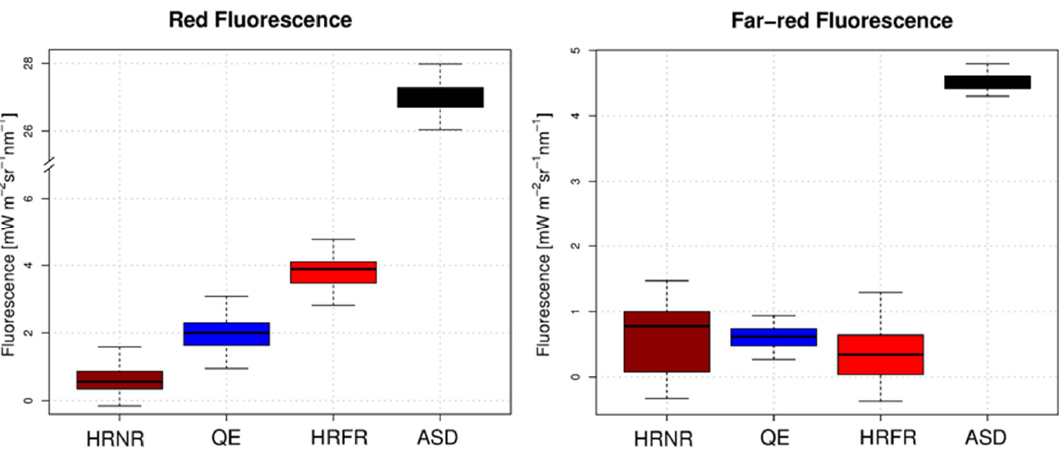
Figure 3. Boxplots of red ( left ) and far-red ( right ) Sun Induced chlorophyll Fluorescence (SIF) retrieval means and associated standard deviations of the 30 cycles of measurements. The instruments are reported in the order according to the increasing Full Width at Half Maximum (FWHM) and Spectral Sampling Interval (SSI). The red SIF estimations differ, indicating a possible dependency on the Spectral Resolution (SR) and SSI of the sensor. The HR4000 Narrow Range (HRNR), QE Pro and HR4000 Full Range show comparable far-red SIF retrieval estimates. SIF estimated from the ASD Fieldspec Pro is extremely high in both the red and far-red cases. The difference in the standard deviations for the far-red SIF estimates (right) can be explained by the differences in the Signal to Noise Ratio (SNR) of these instruments.